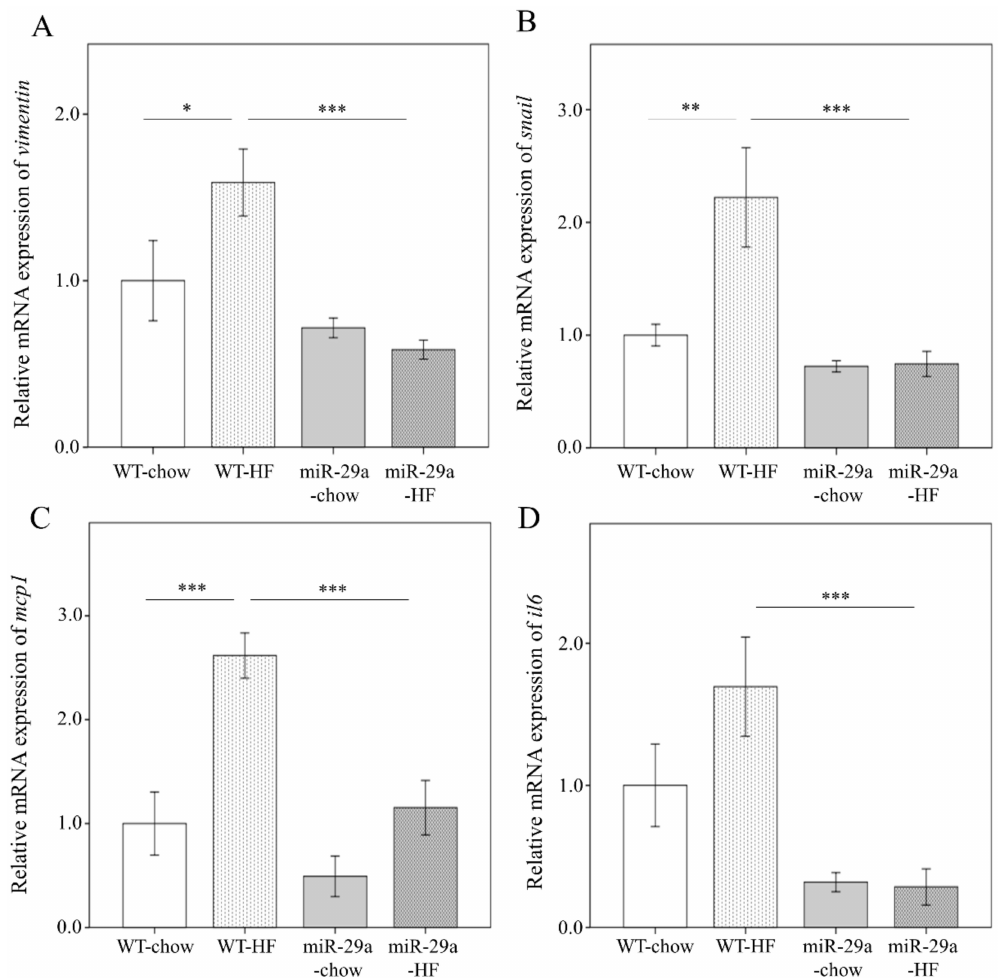
Figure 5. Overexpression of miR-29a represses hepatic epithelial-mesenchymal transition and inflammation in the context of chronic HFD. mRNA expression level of ( A ) vimentin, ( B ) snail, ( C ) mcp1, and ( D ) il6. β -actin level is used as the normalization control. Five to seven specimens were used for each group. Data are expressed as mean ± SE. * p < 0.05, ** p < 0.01 and *** p < 0.001 between the indicated groups. WT, wild type mice. HFD, high-fat diet. miR-29a, mice harboring overexpression of